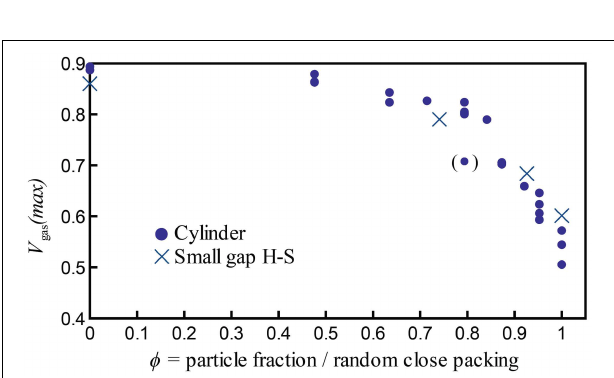
FIGURE 9 | Tracks of column height with time over the full lifespan of four experiments with foams (generated via chemical reactions) in cylinder geometries, with particle fractions of 40, 55, 60, and 63%. Note that the 55% line shows characteristics of both regimes: early onset oscillations and low maximum growth, as well as large oscillations (accompanied by the rise of large bubbles) and a final deflation.